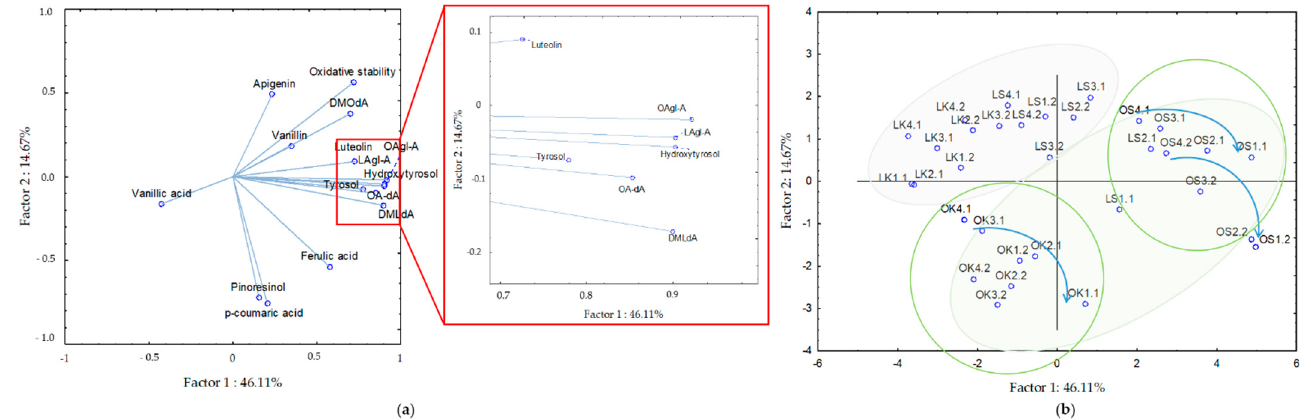
Figure 2. ( a ) Diagram of the loadings for the composition of phenolic compounds and oxidative stability obtained by principal component analysis; and ( b ) projection of the samples of Oblica (O) and Leccino (L) virgin olive oils grown in Kaštela (K) and Šestanovac (S) during fruit ripening (1–4, harvest period) in two growing seasons (1–2, number after the